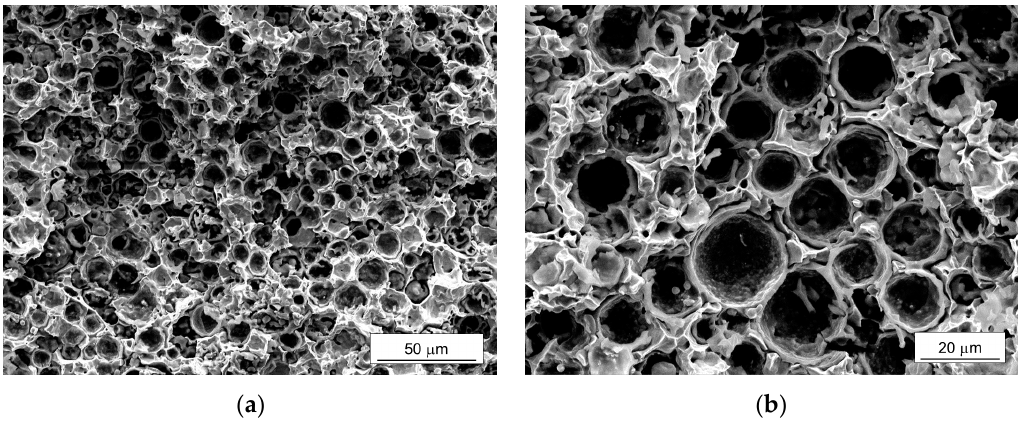
Figure 10. Fracture surfaces of the iron syntactic foam with 5 wt % hollow glass microspheres after the tensile test observed by scanning electron microscope: ( a ) Low magnification; and ( b ) high magnification.